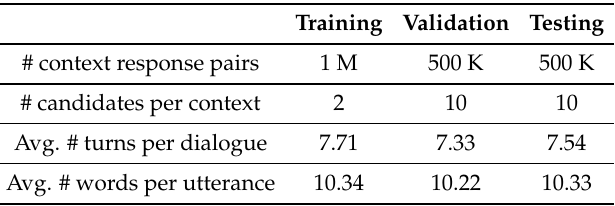
Table 2. Statistics of Ubuntu Corpus